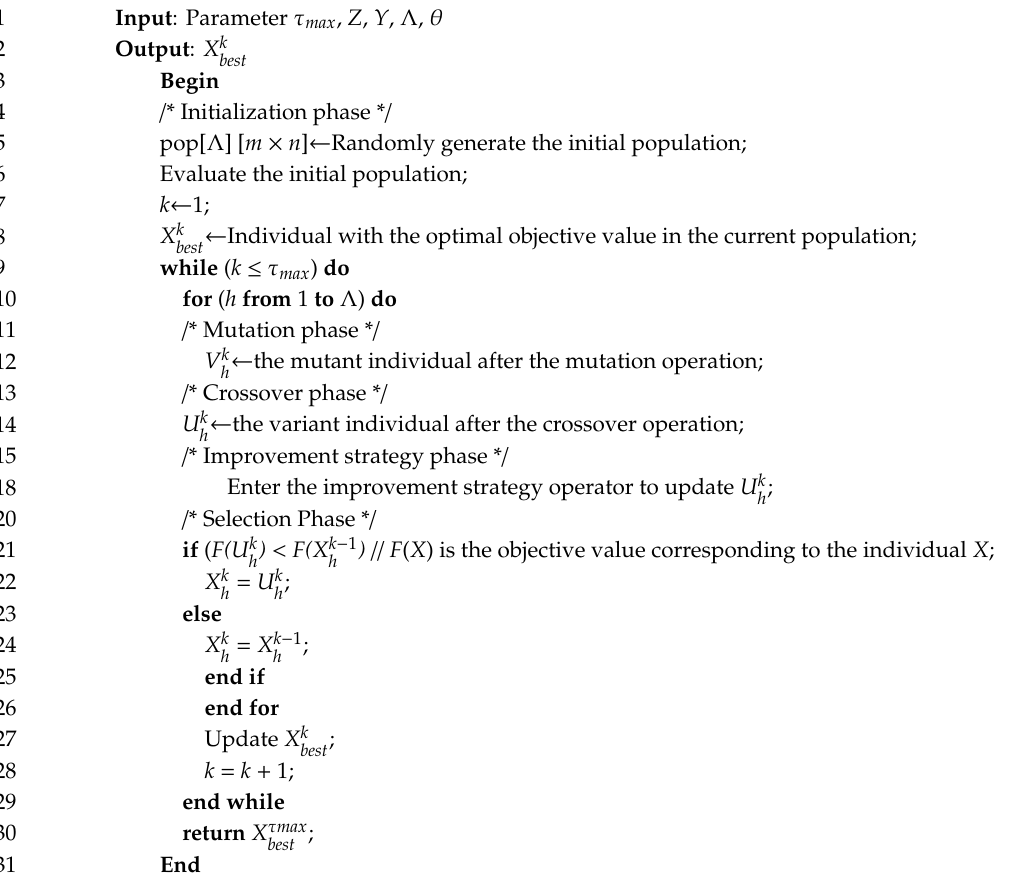
Algorithm 1: the HDDE